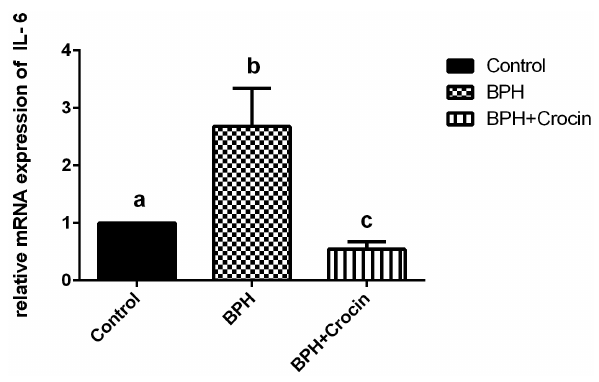
Fig. 6. IL-6 mRNA expression in the experimental rats show- ing the effect of crocin treatment. The data represent the mean ± SEM. Means with different superscript letters are significantly different from one another ( P < 0.05). Abbreviations: BPH, be- nign prostatic hyperplasia; IL-6,